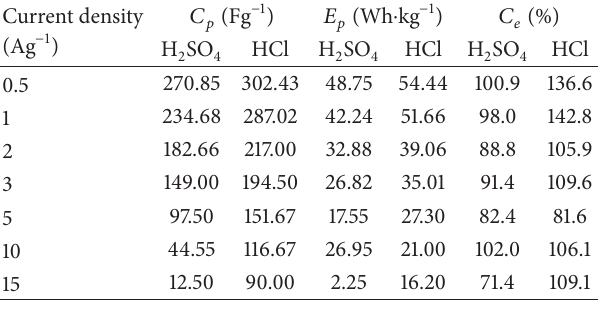
Table 1: The values of specific capacitance ( 𝐶 𝑝 ), specific energy ( 𝐸 𝑝 ), and coulombic efficiency ( 𝐶 𝑒 ) of PANI from charge/discharge curves at current density from 0.5 Ag − 1 to 15Ag − 1 in 1 M HCl and 1 M SO . H 2 4